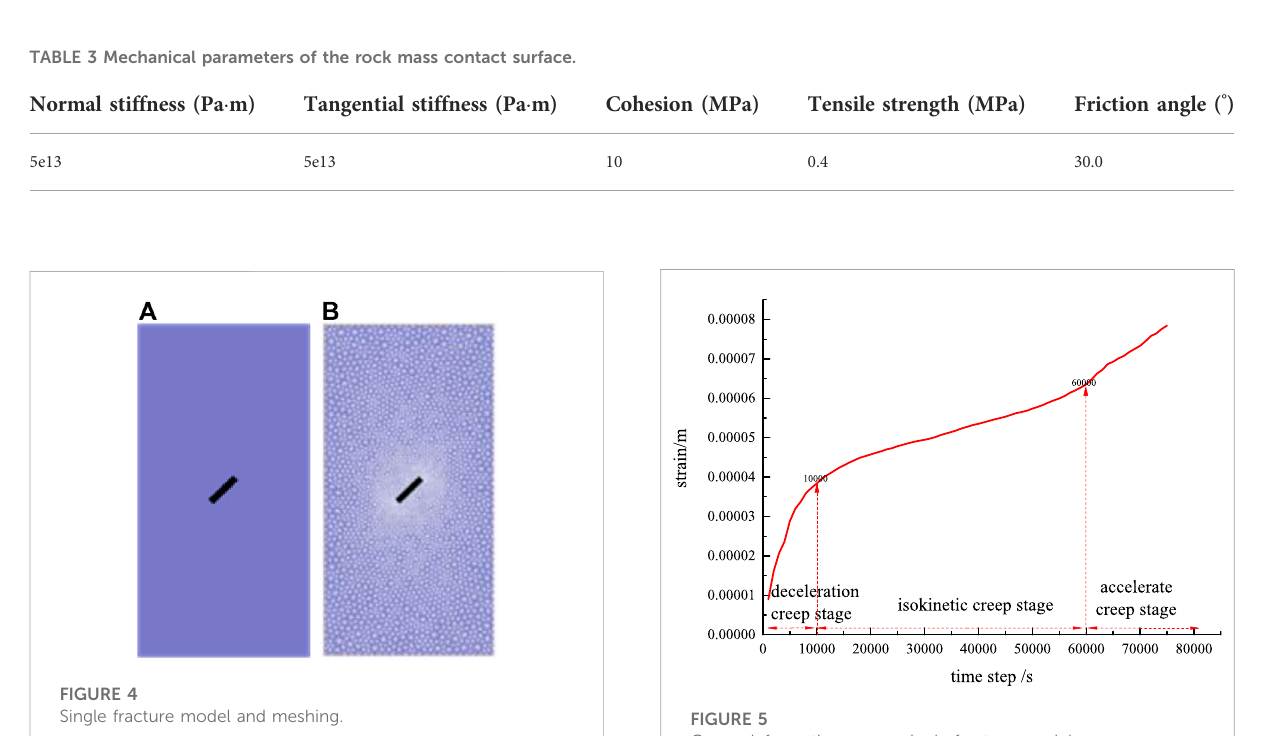
Creep deformation curve: single fracture